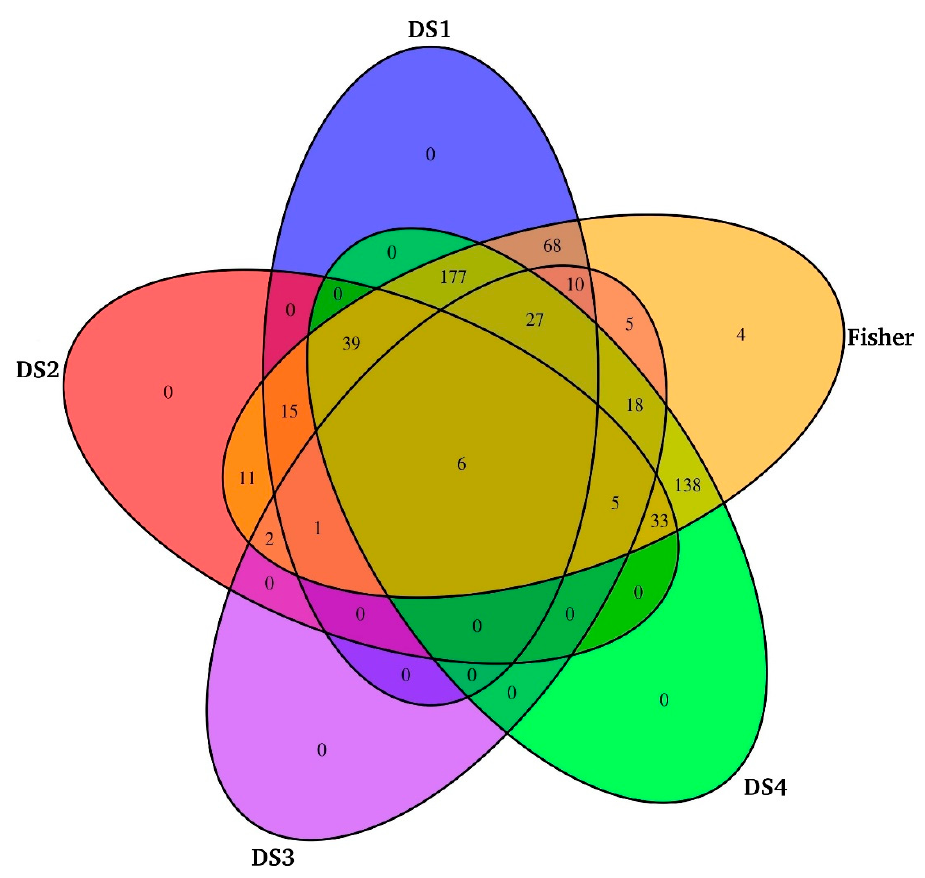
Figure 1. Venn diagram showing the number of differentially expressed transcripts identified from individual studies and meta-analysis based on the Fisher method. Among the list of 405 DETs, six (including one of the topmost upregulated, SUCLG2 ) were identified as DE across all four datasets, as well as by the Fisher method (Table